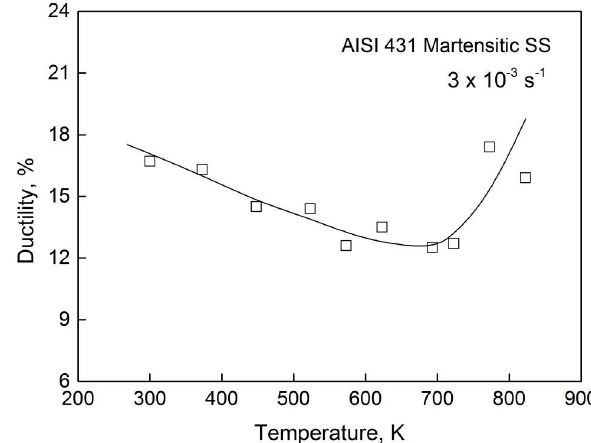
Figure 3: Variation of ultimate tensile strength with temperature for the AISI 431 steel.